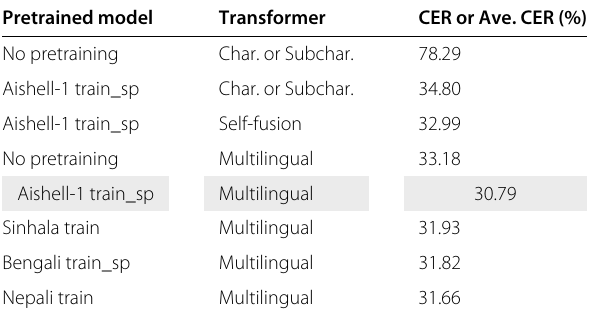
Table 5 Performance of different Lhasa dialect modeling units, self-fusion systems (pretrained by Aishell-1 train_sp) and multilingual speech recognition systems with multi-level modeling units (pretrained by different